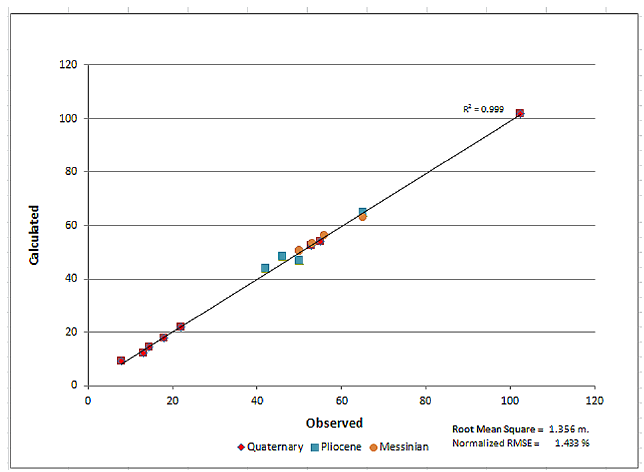
Figure 8. Model calibration of observed versus simulated hydraulic heads.